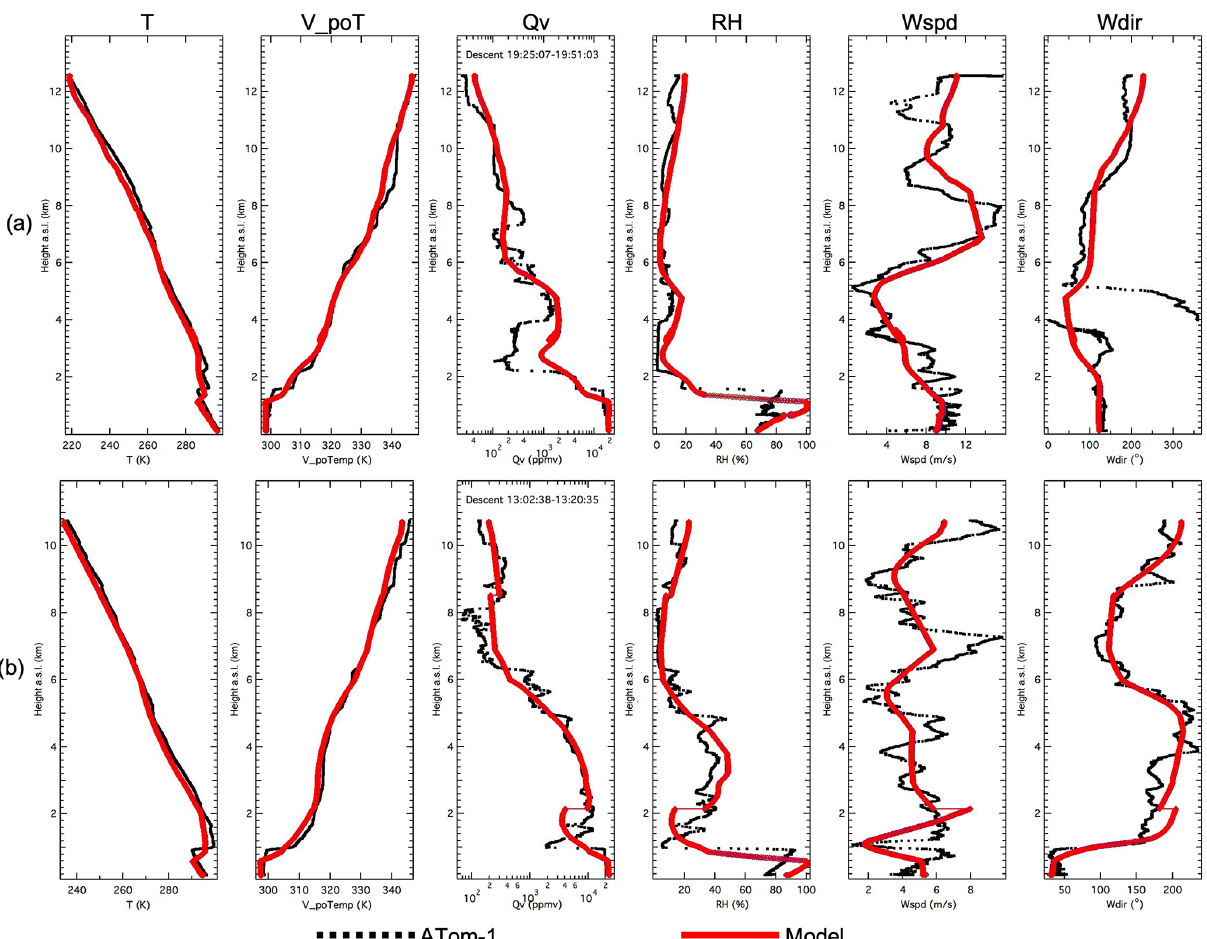
Figure 8. ATom-1 observations and model results for temperature, virtual potential temperature, water vapor, relative humidity, wind speed, and wind direction in the (a) biomass burning and (b) dust events. The biomass burning plume is from 15 August 2016, profile no. 16 near 20 ◦ S, while the Saharan dust plume is from 17 August 2016, profile no. 10 near 25 ◦